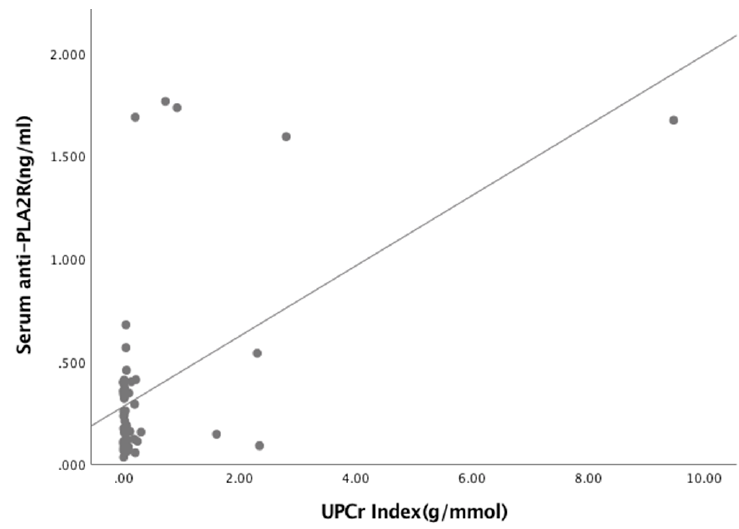
Figure A4. Relationship between Serum anti-PLA 2 R and UPCr Index (R = 0.502, p < 0.001).